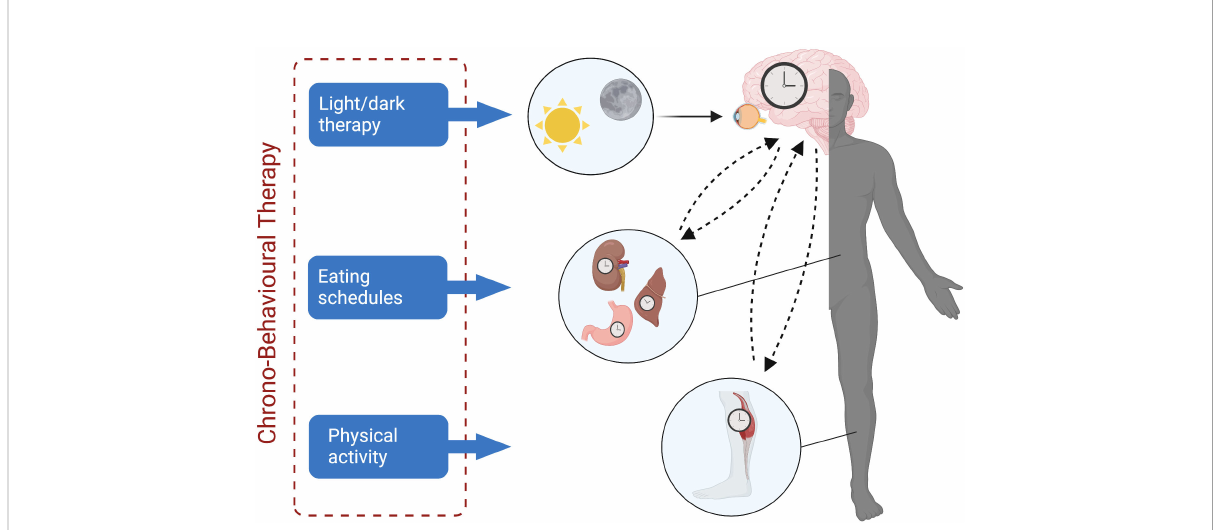
FIGURE 2 Entrainment of central and peripheral clocks through targeted interventions. Strengthening of the circadian system through direct entrainment of the central clock (i.e., the suprachiasmatic nucleus) may occur through implementation of light/dark therapy; entrainment of peripheral clocks may occur through interventions that target the timing of eating and physical activity. Created with